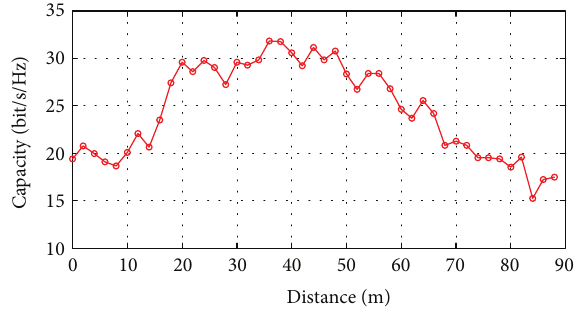
Figure 9: Capacity coverage of D-MIMO system in corridor